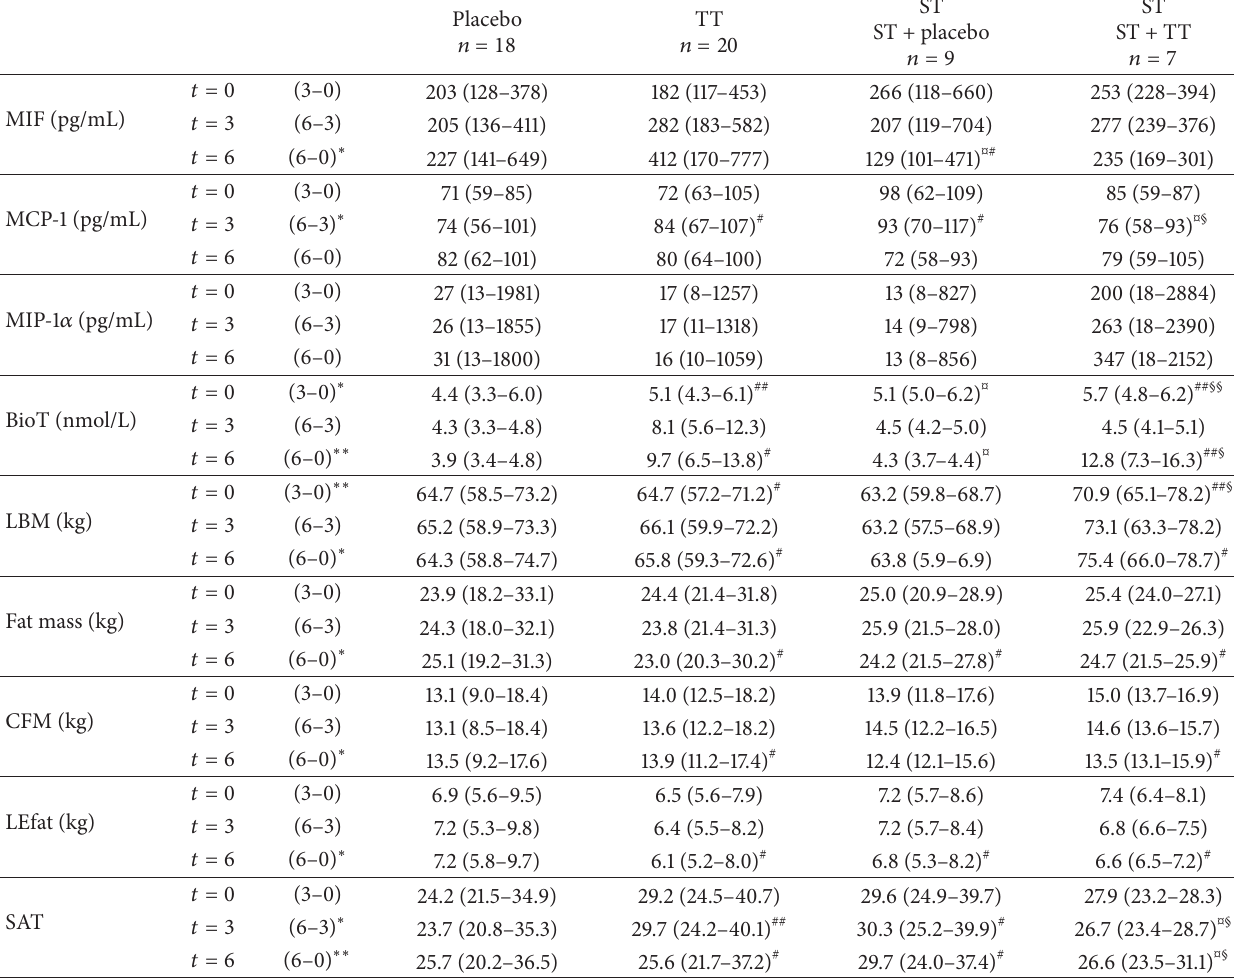
Table 2: Clinical and biochemical characteristics in patients during testosterone, placebo, and strength